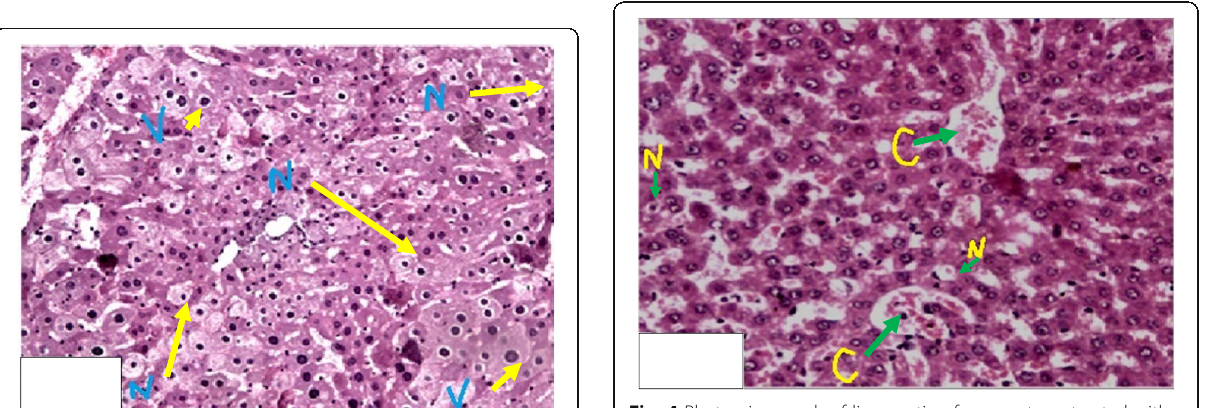
Fig. 4 Photomicrograph of liver section from a rat pre-treated with a 1000 mg/kg dose of aqueous-methanolic MO leaf extract and four times the clinical dose of ASAQ. (Magnification ×400). C = Hepatic vein congestion, N = Hepatic cell